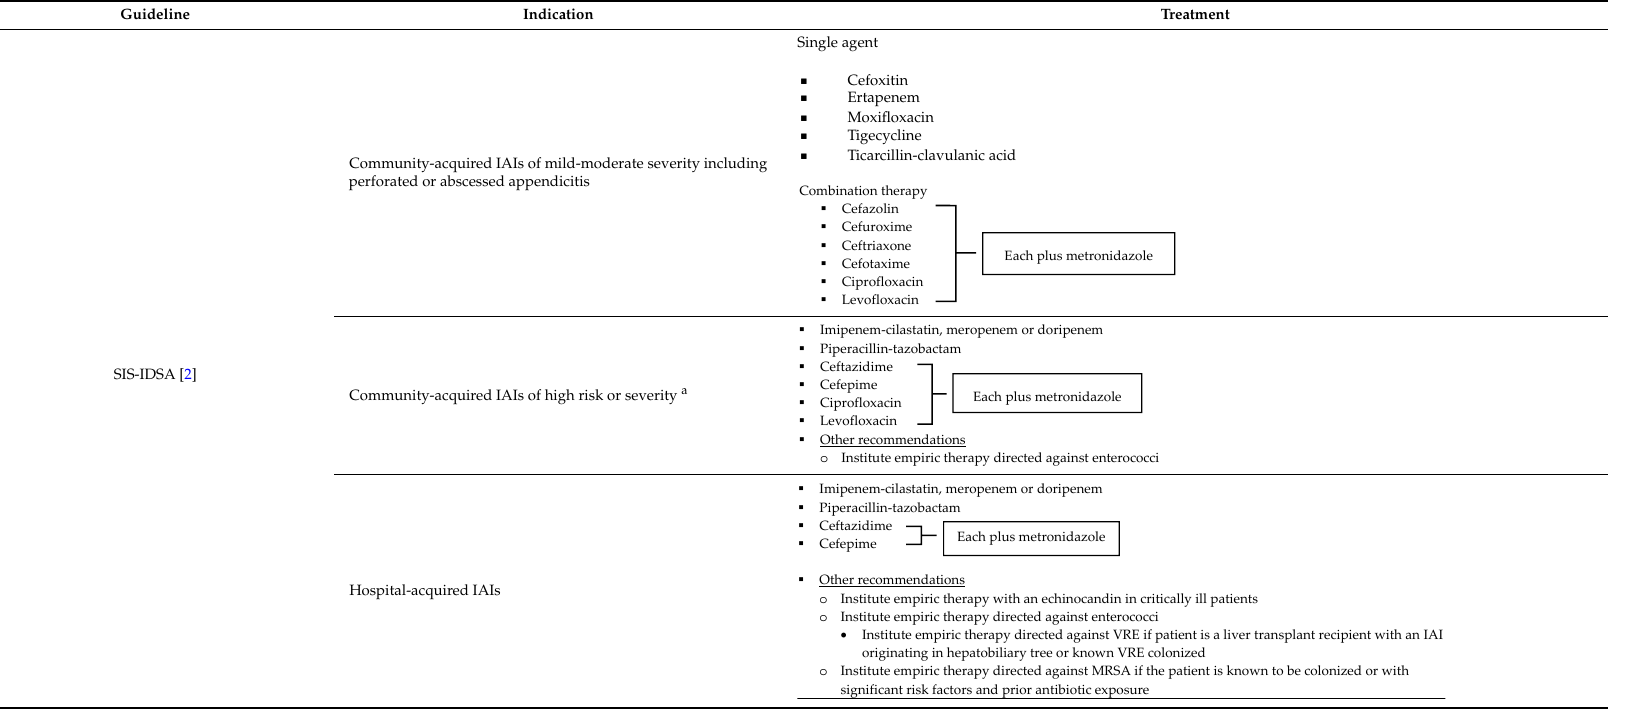
Table 2. Antimicrobial treatment recommendations for appendicitis and extra-biliary IAIs in adults. Guideline